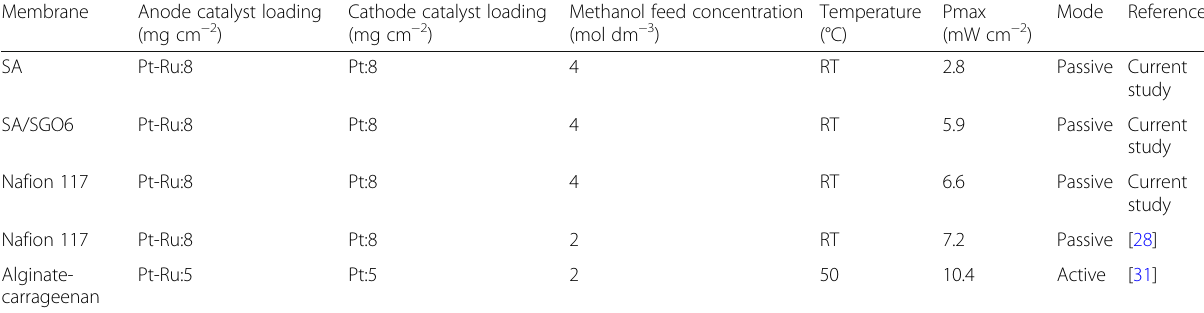
Table 2 Comparison of condition in single-cell performance test with power density result for previous work and current study